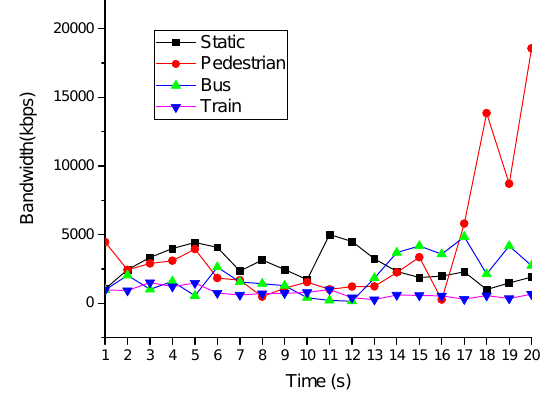
Figure 4. Network